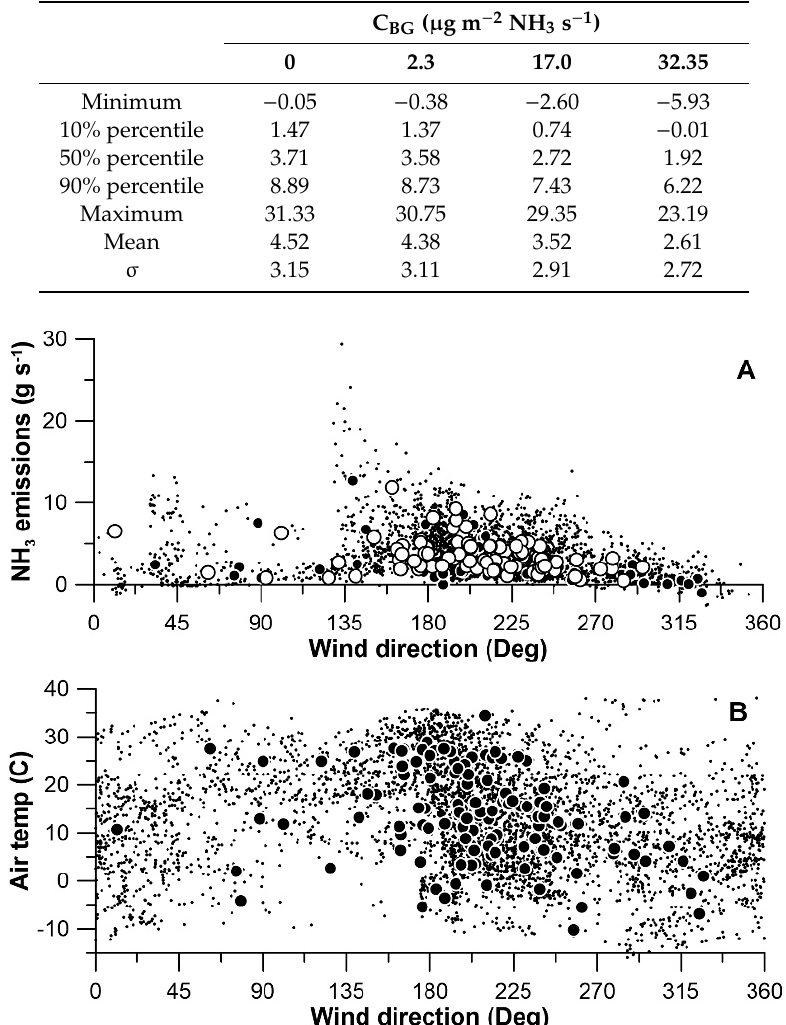
Figure 3. Influence of wind direction on NH 3 emissions. Variation in half-hour NH 3 emissions (small filled circles), daily NH 3 emissions (filled large circles) and representative daily NH 3 emissions (open large circles) are illustrated in panel ( A ). The air temperatures during the half-hour NH 3 emission (small filled circles) and daily emissions (large filled circles) are indicated in panel ( B